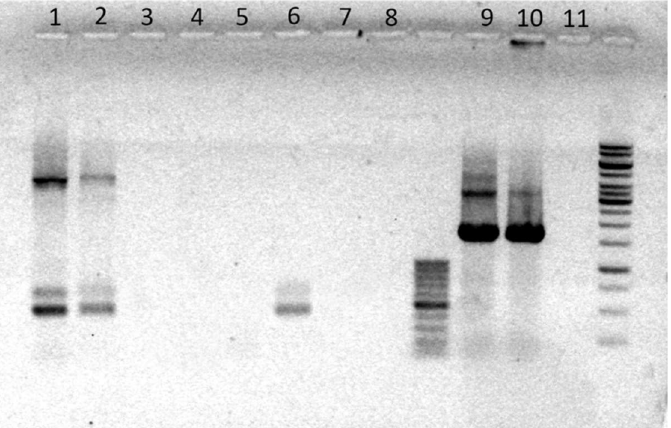
Figure 8. PHMG-Cl–DNA complexes prevent PCR amplification of target sequences in pC1-L plasmid DNA and eDNA. Shown here is a 1.2% agarose-TA gel stained with EtBr to visualize PCR products after amplification with pL1-C LIF gene or 16S-specific primers. CCC pC1-L DNA